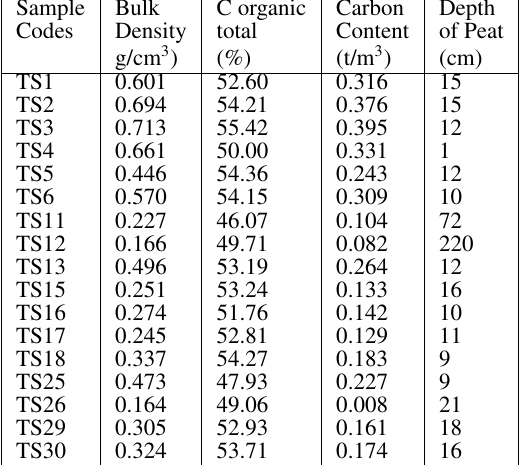
Table 1. Carbon content parameters of peatland extracted by in-situ surveys in Banjar Regency and Banjarbaru City,